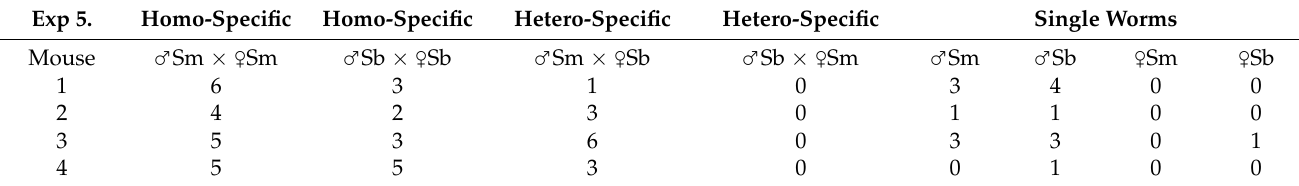
Table 4. Summarized information of homo-specific pairs, hetero-specific pairs and unpaired worms recovered from mice exposed to simultaneous infections to full combinations of cercariae.